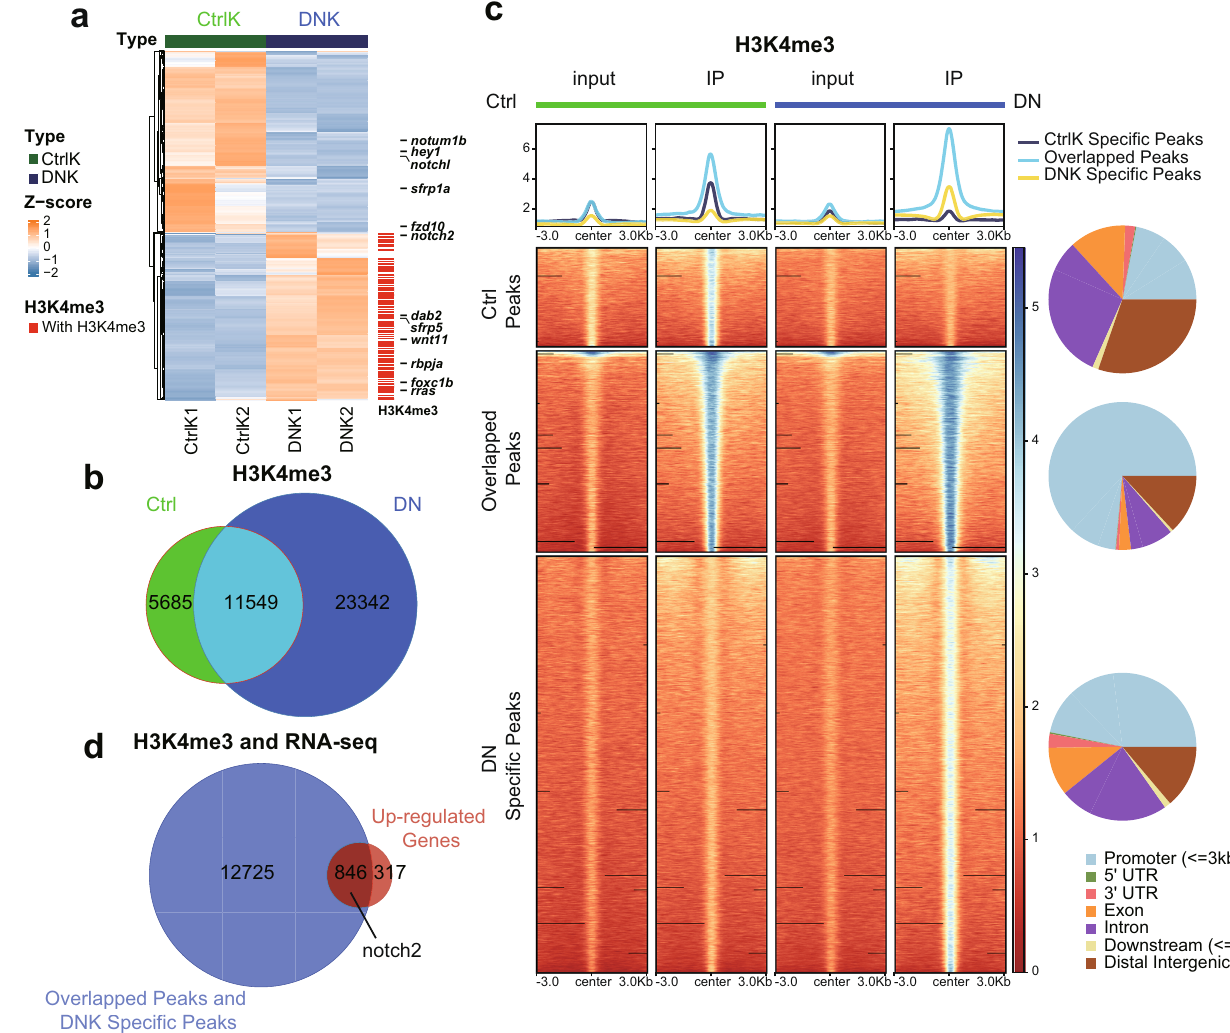
Fig. 2 Endothelium-speci fi c inhibition of Brg1 changes the levels of H3K4me3 in the promoter regions of the zebra fi sh genome. a Heatmap displaying Z- score normalized gene expression for differentially expressed genes between FACS-sorted kdrl:EGFP endothelial cells from dominant-negative Brg1 groups (DNK1 and DNK2) and control groups (CtrlK1 and CtrlK2). FPKM value of each gene was normalized using Z -scores across samples. Columns represent individual samples (two biological replicates for each group); rows represent differentially expressed genes ordered by hierarchical clustering. Labeled genes are part of the differentially expressed Notch signaling genes. The upregulated genes in the DNK group that were labeled with ‘ red color ’ had H3K4me3 peaks in their promoters. b Venn plot representing the intersection of H3K4me3 peaks between Ctrl and DN groups. c Heatmaps and summary plots displaying the signal pro fi le of normalized read coverage around three categories of H3K4me3 peaks across different samples. The read coverage was normalized to 1x sequencing depth in all samples. Each row of the heatmap represents one peak, with coverage plotted across the 3 kb surrounding the peak summit. H3K4me3 peaks were classi fi ed into three categories: Ctrl-Speci fi c Peaks represent peaks speci fi cally in the Ctrl group; Overlapped Peaks represent peaks overlapped between the Ctrl and DN groups; DN-Speci fi c Peaks represent peaks speci fi cally in the DN group. The genomic distribution for three types of peaks is presented with pie charts on the right side. d Venn plot representing the intersection between genes with promoters marked by Overlapped Peaks and DN-Speci fi c Peaks and genes that were differentially upregulated in the DNK